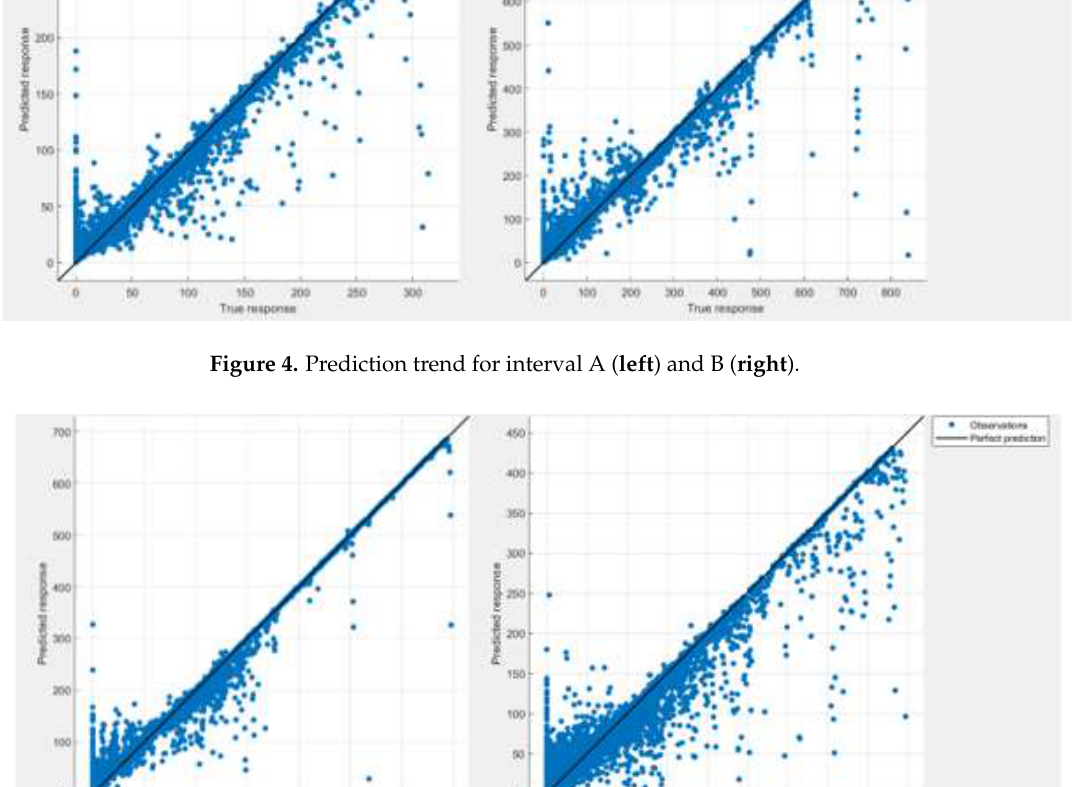
Figure 5. Prediction trend for interval C ( left ) and D ( right ).